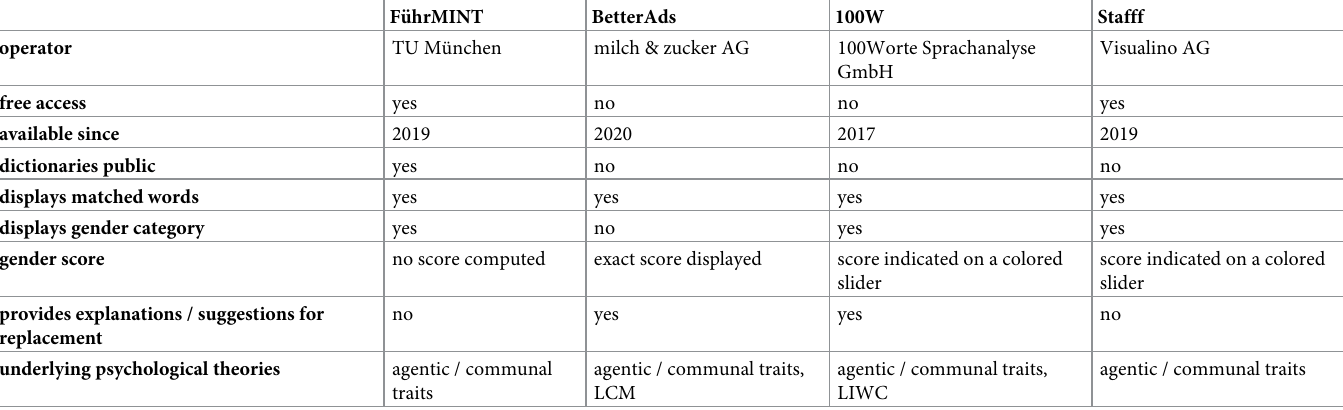
Table 1. Overview of the four technologies for detecting gender-exclusionary language in German-language job postings.